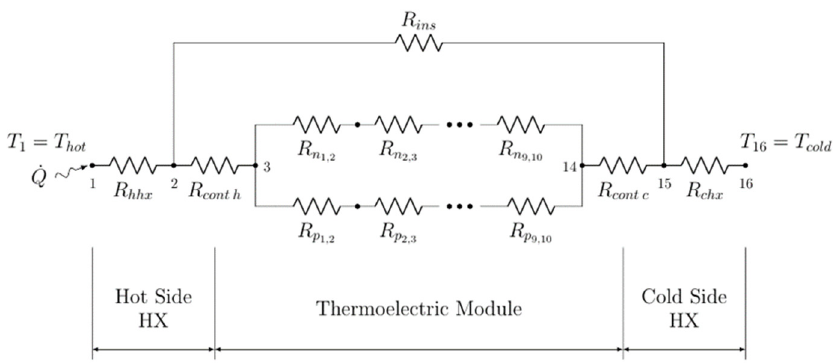
Figure 3. Schematic of the thermal resistances of the simulated TEGs.